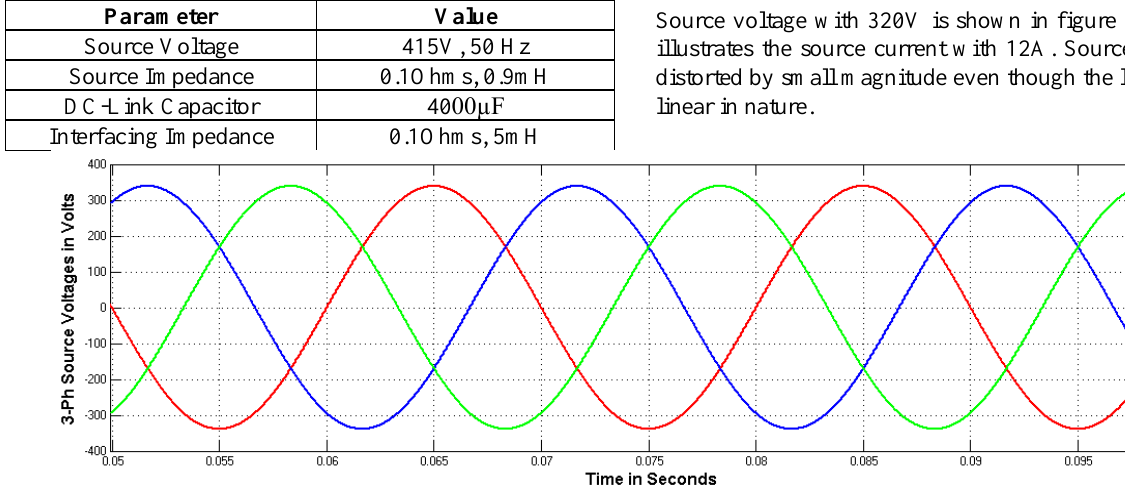
Table 1. System parameters